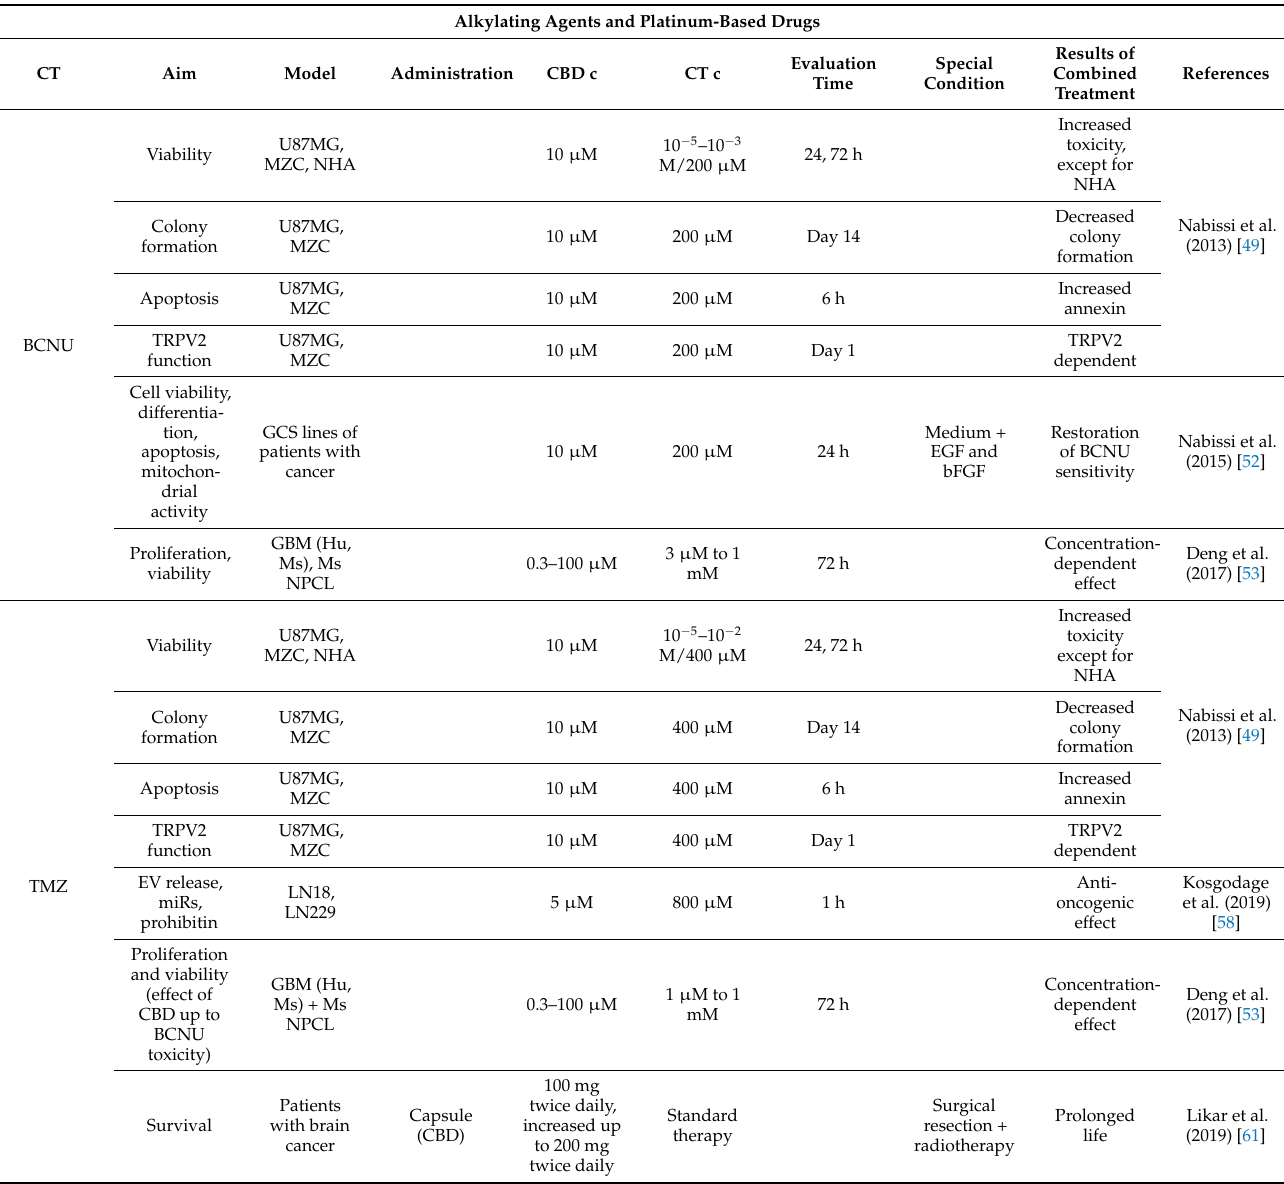
Table 2. Summary of the drug–drug interactions of CBD with alkylating agents and platinum-based drugs. Alkylating Agents and Platinum-Based